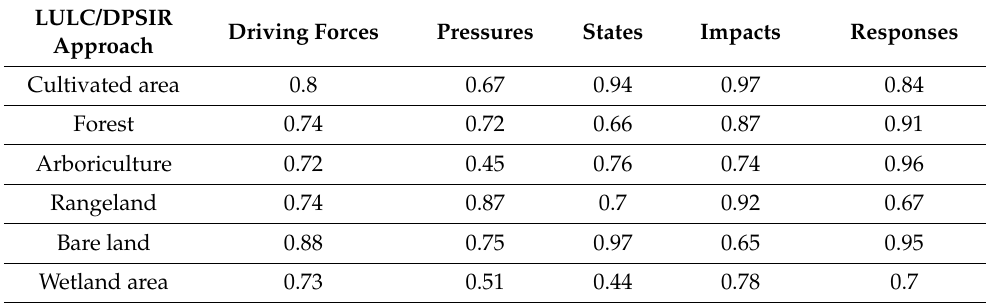
Table 11. Determination coefficient (R 2 ) for LULC types of culture and the probability of occurrence for the DPSIR approach of LULC types of culture dynamics as perceived by